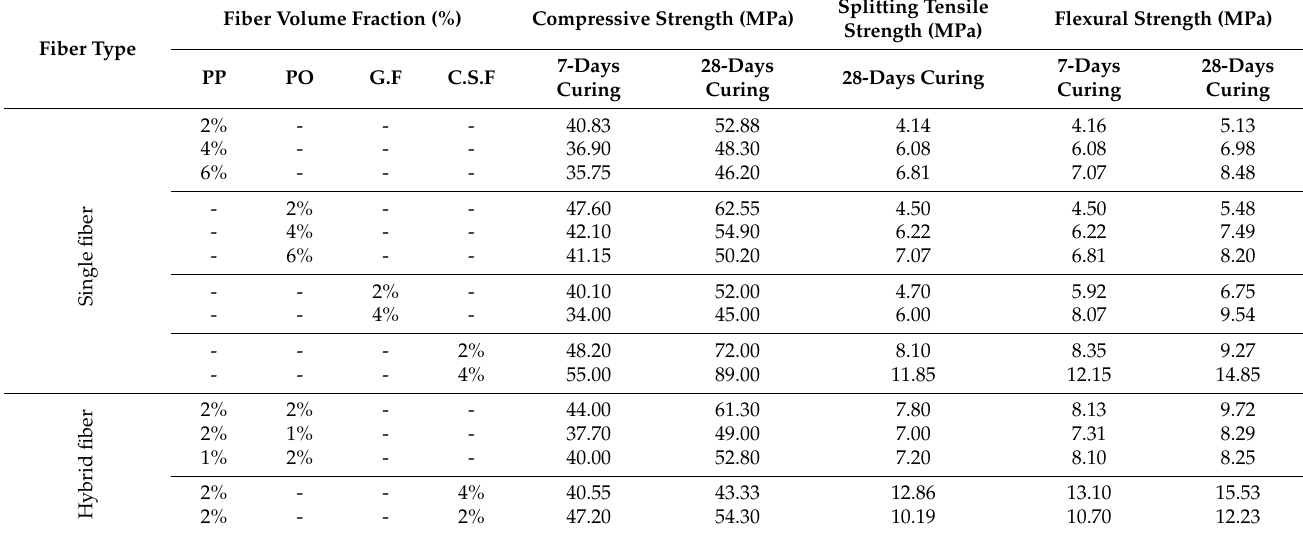
Table 6. Mechanical properties of FRC and ECC specimens at 7 and 28 days.